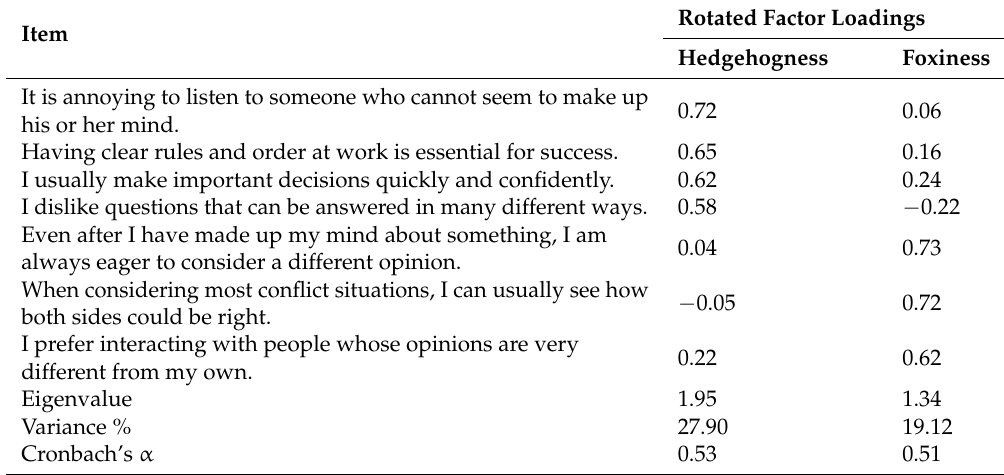
Table 2. Results of the Exploratory Factor